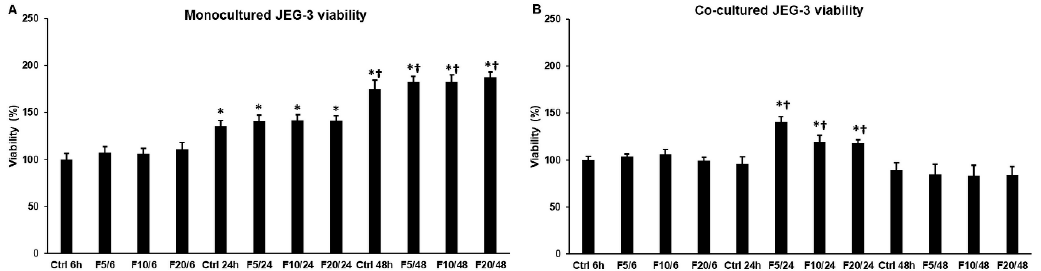
Figure 1. Cell viability determinations of the mono- and co-cultured JEG-3 cells. Viability was measured using CCK-8 cell viability assay after fractalkine treatments. Viability is expressed as percentile of the total cell number of the untreated control cells. ( A ) Viability of the monocultured JEG-3 cells and ( B ) Cell viability measurements of co-cultured JEG-3 cells. Cell viability assays were made in quintuplicate in three independent experiments. The bars represent mean values and error bars represent standard deviation (SD) for three independent experiments ( n = 3). The * indicate p < 0.05 compared to the 6 h untreated control. The † indicate p < 0.05 compared to the 24 h untreated control. Abbreviations of fractalkine treatments: 5 ng / mL-F5; 10 ng / mL-F10; 20 ng / mL-F20.